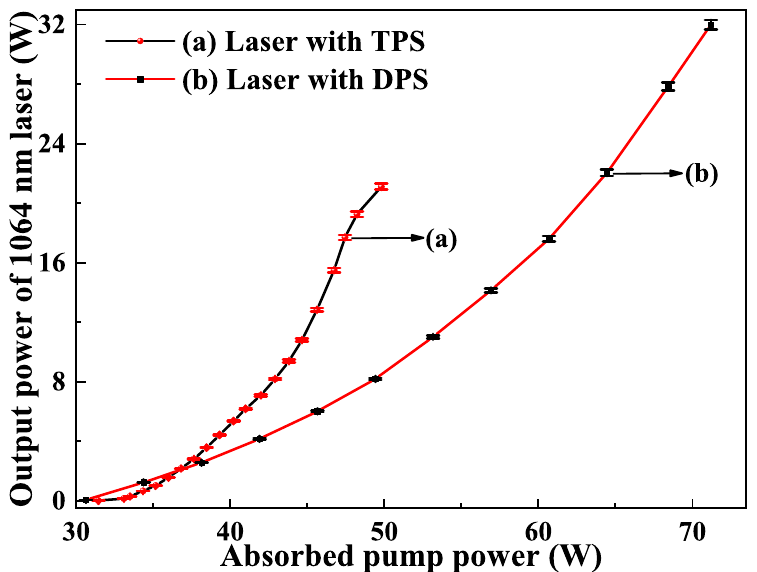
Figure 21. Output power of the 1064 nm laser versus the incident pump power [32]. Reprinted with permission from [32] c (cid:13) The Optical Society.